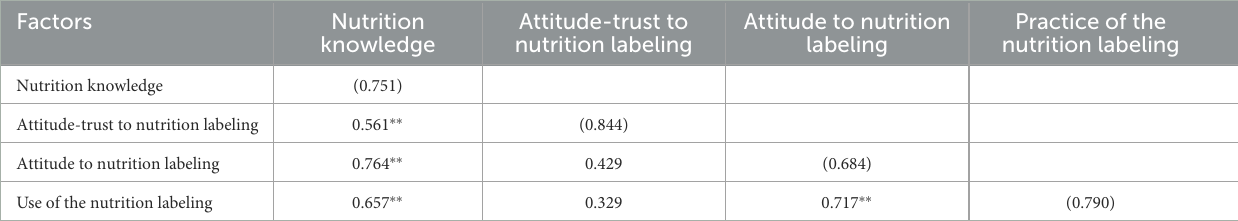
TABLE 5 Factor correlations and discriminant